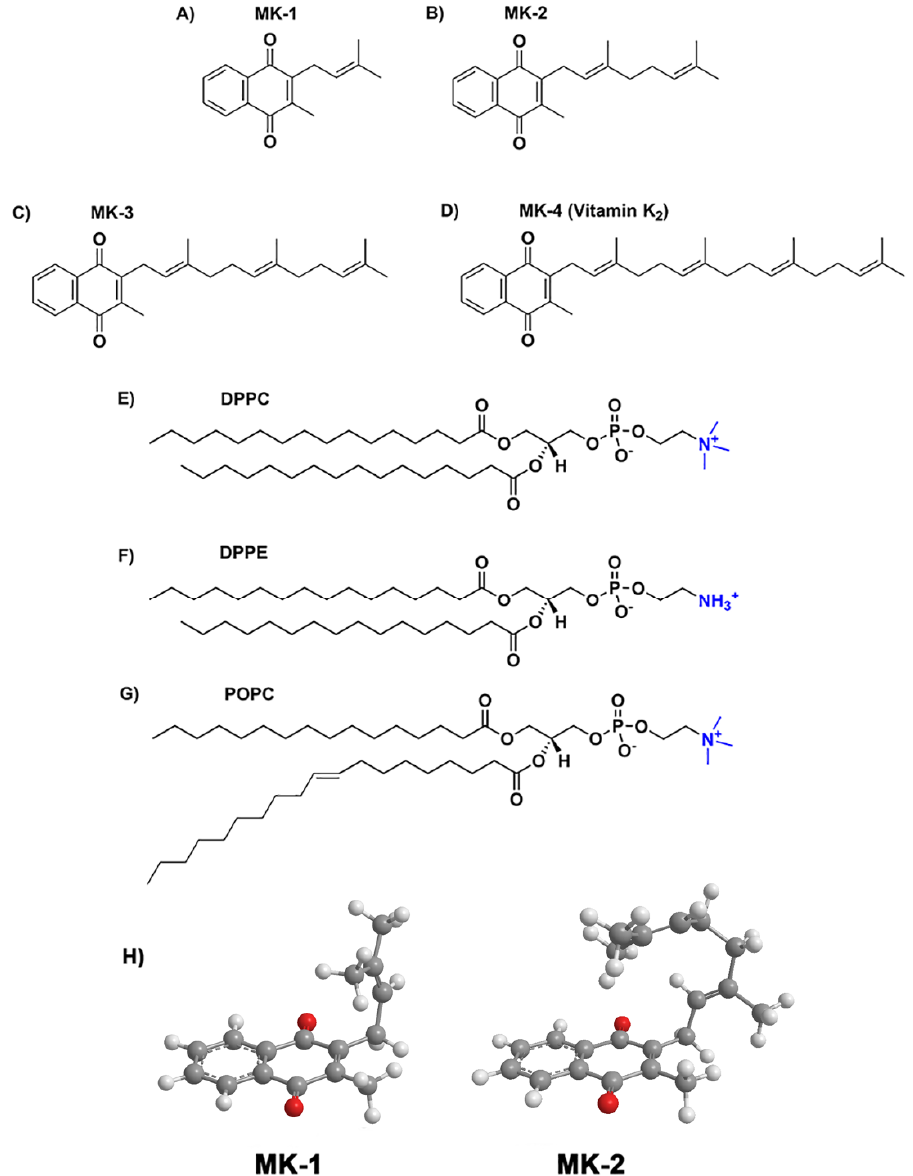
Figure 1. The structures of MK-1 through MK-4 ( A – D ) and the phospholipids ( E ) dipalmitoylphosphatidylcholine (DPPC), ( F ) dipalmitoylphosphatidylethanolamine, and ( G ) palmitoyloleyoylphosphatidylcholine (POPC). Conformations of ( H ) MK-1 and MK-2 within the AOT reverse micelle interface are also shown (adapted from Koehn et al. 2018 and Koehn et al. 2019) [6,7].